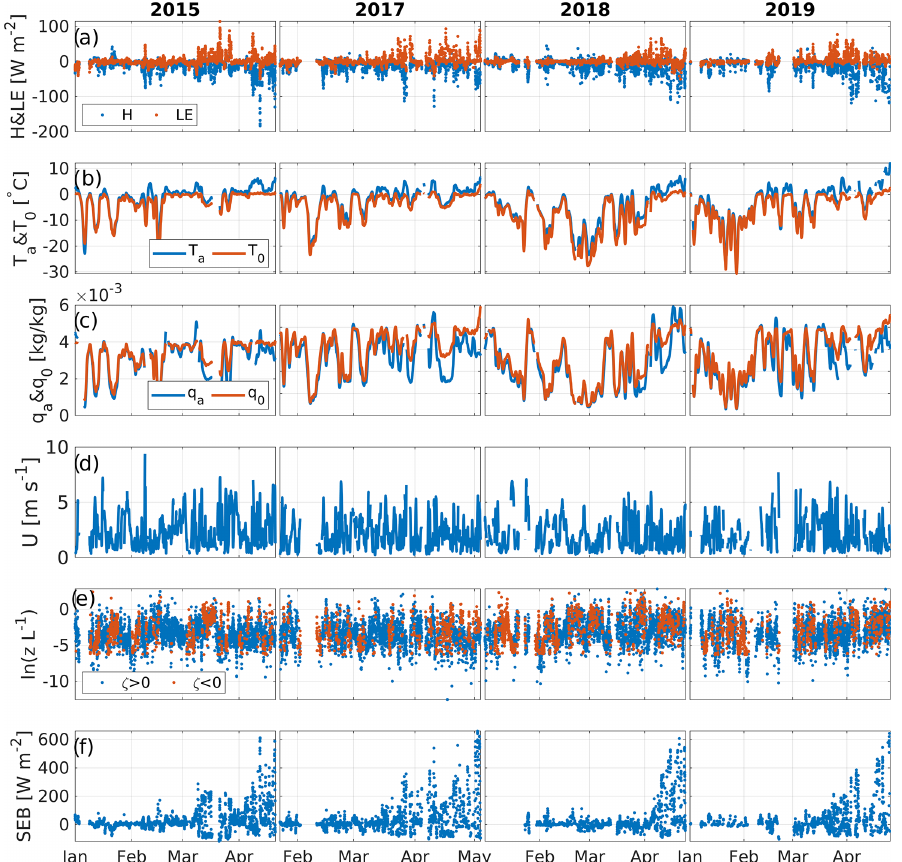
Figure 4. All four winters of (a) turbulent flux data, (b) air and surface temperature, (c) air and surface humidity, (d) wind speed, (e) natural logarithm of stability and (f) surface energy balance (SEB). Each column represents one winter. All data are presented as half-hourly values, except for wind, which is presented as a 6h moving mean. Note that the surface energy balance notation is such that positive values indicate heat flux into the surface and vice